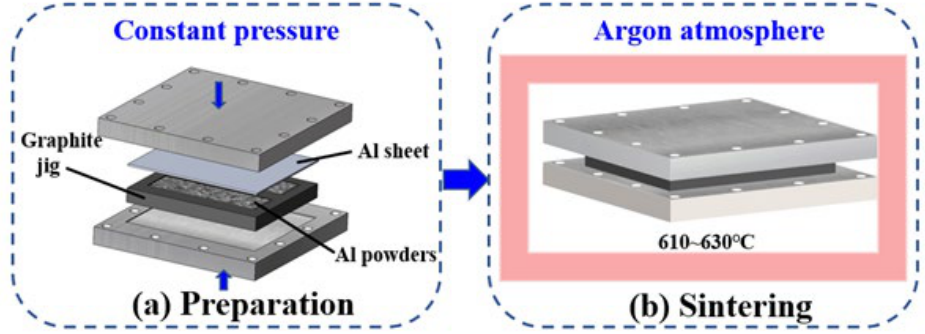
Figure 1. Preparation method of sintered aluminum powder wick. Table 1. Experimental sample parameters.